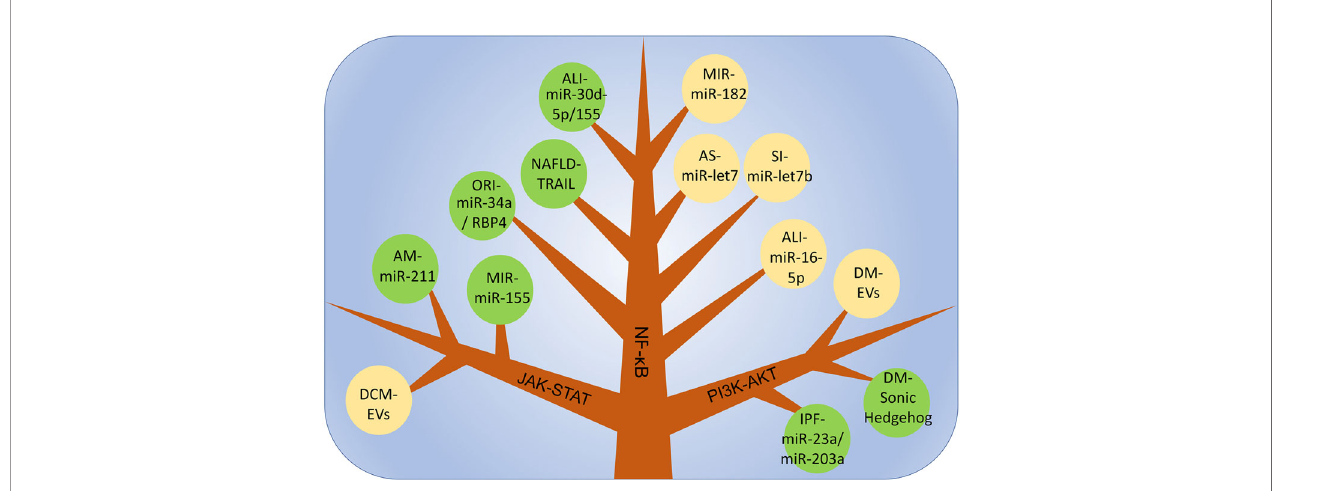
FIGURE 3 | The main mechanism of macrophage polarization is in various in fl ammatory diseases. DCM , dilated cardiomyopathy; AM , acute Mastitis; MIR , myocardial ischemia-reperfusion injury; ALI , Acute lung injury; NAFLD , non-alcoholic fatty liver disease; ORI , Obesity-related in fl ammation; SI , Skin in fl ammation; AS ,